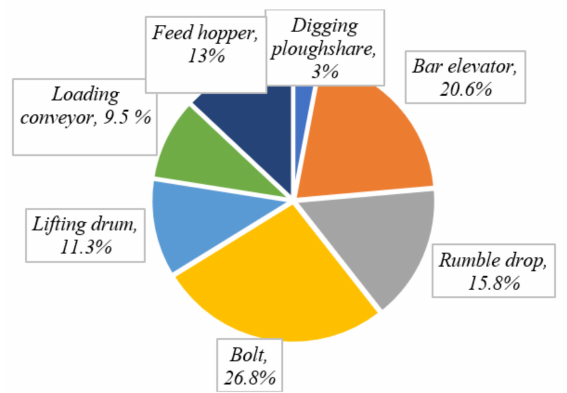
Figure 3. The share of work elements in the damage of potato tubers (percentage of the total damage number by